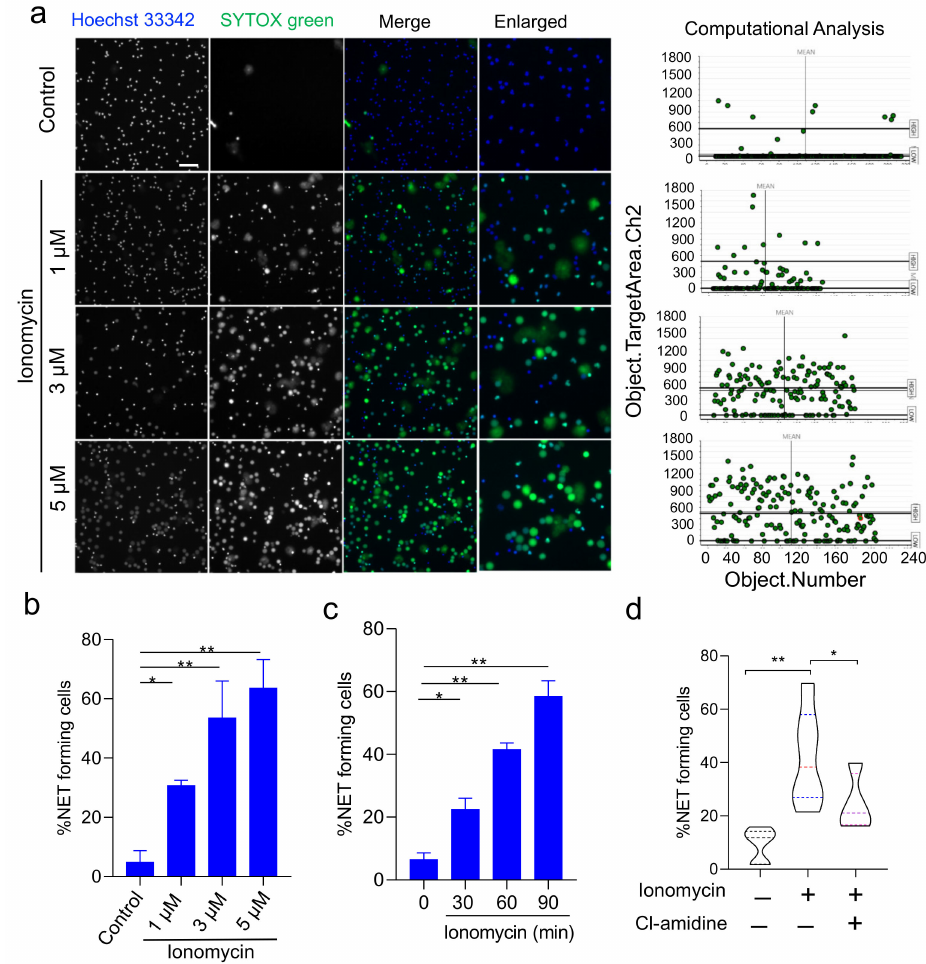
Figure 3. Ionomycin-induced NETs and HCS Cellomics-based analysis. ( a ) Left side, representative images of control, Ionomycin-treated neutrophils acquired at 20 × objective. The cells were treated with different concentrations of ionomycin for 90 min as indicated in the figure and analyzed based on Hoechst 33342 and Sytox green staining with decondensation of nucleus. Scale bar; 50 µ m. Right side scattered plots represent target area in channel 2 (sytox green channel) used for identification of cells forming NETs with enlarged decondensed nucleus. ( b ) The concentration and ( c ) time-dependent effect of Ionomycin on NET formation from human neutrophils. ( d ) Effect of 100 µ M PAD inhibitor Cl-amidine on Ionomycin-induced NETs. * p < 0.05, ** p < 0.01; Data are means ±